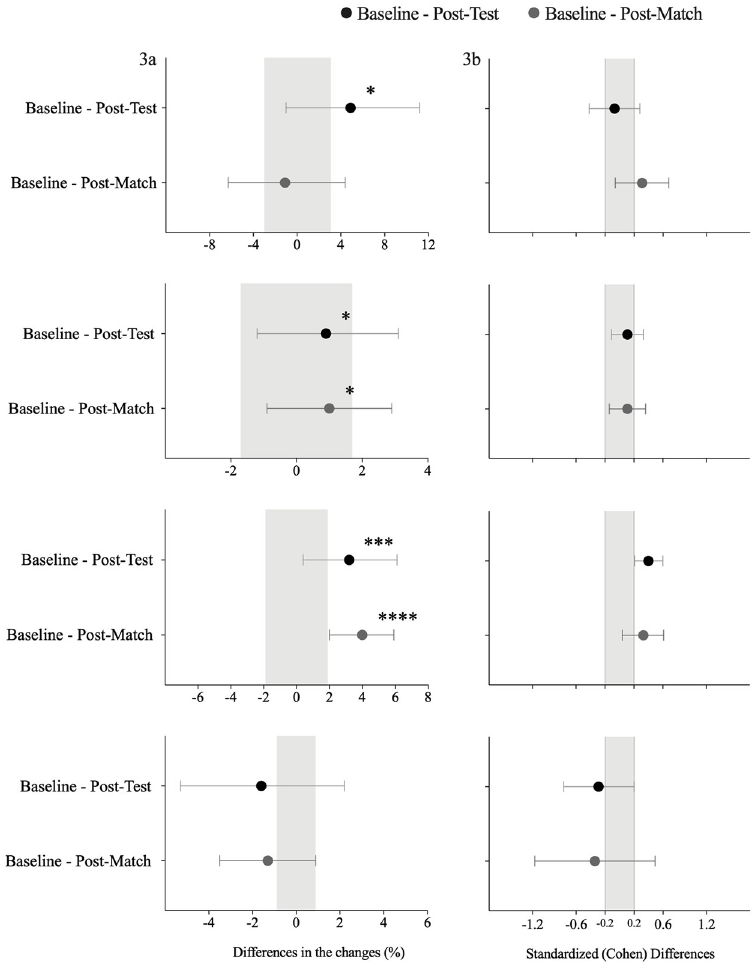
Fig 3. Effects of the traditional intervention (a) and differential learning intervention; (b) on CMJ (i), Ball Impact (ii), Average velocity (iii) and Accuracy (iv). Gray solid lines indicate individual responses, while black dotted lines indicated group mean value. Also, standardized (Cohen) differences; (c) of variables between the traditional and differential learning groups (black � mark represents the comparison between baseline and post-test, while the grey � mark represents the comparison between baseline and post-match test). Error bars indicate uncertainty in the true mean changes with 90% confidence intervals. Abbreviation: CMJ = countermovement jump.